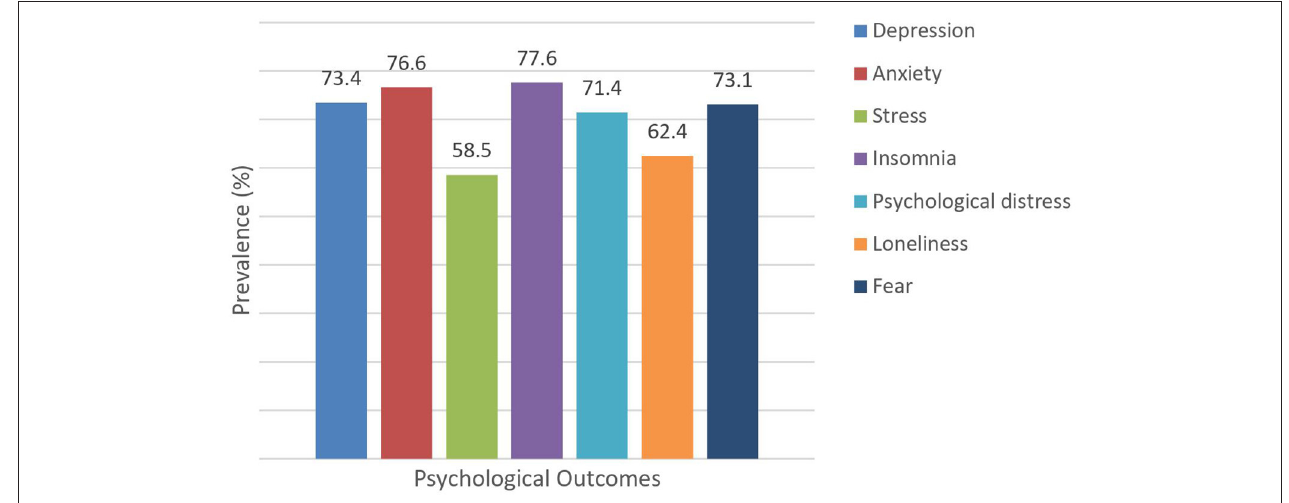
FIGURE 2 | Prevalence of psychological outcomes during the COVID-19